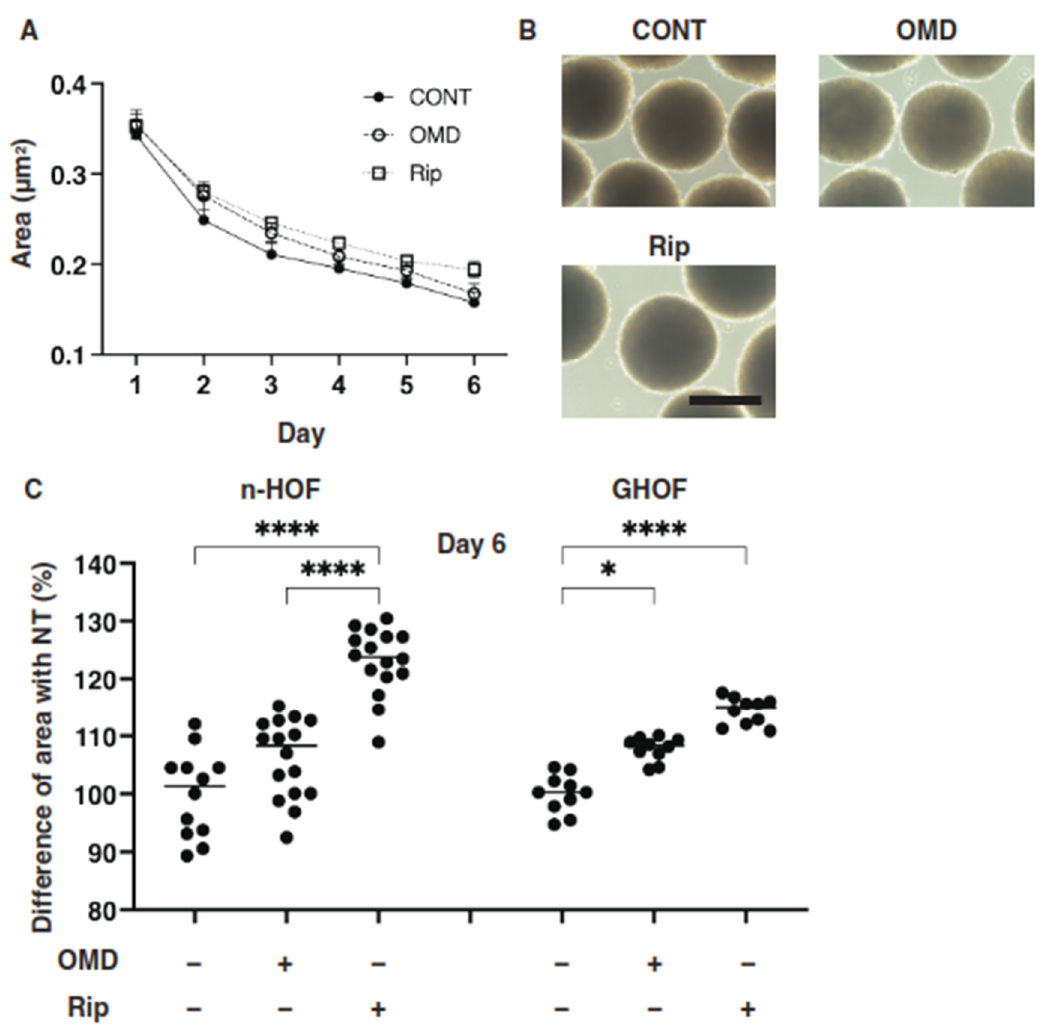
Figure 1. Effects of omidenepag (OMD) and ripasudil (Rip) on the mean sizes of n-HOFs or GHOF 3D spheroids. Panel ( A ) Changes in the mean area sizes ( µ m 2 ) of the 3D spheroids derived from n-HOFs cells cultured without (CONT, closed circles) or with 100 nM omidenepag (OMD, closed squares) or 10 μM Ripasudil (Rip, closed triangles) were plotted during the 6-day culture period. Panel ( B ) Representative phase contrast images of the 3D n-HOFs spheroids under several con- ditions as above at Day 6 are shown (scale bar; 100 μm). Panel ( C ) Percentage difference in the size of the mean area of n- HOF or GHOF spheroids treated with omidenepag (OMD) or ripasudil (Rip) as above, as compared with their non-treated control (CONT), was plotted. In terms of the results for the GHOF spheroids, corresponding data reported in our previous study [11] were recalculated and replotted. All experiments were performed in triplicate using fresh preparations, each consisting of 16 spheroids. Data are presented as the arithmetic mean ± the standard error of the mean (SEM). * p < 0.05, **** p < 0.001 (ANOVA followed by a Tukey’s multiple comparison test).